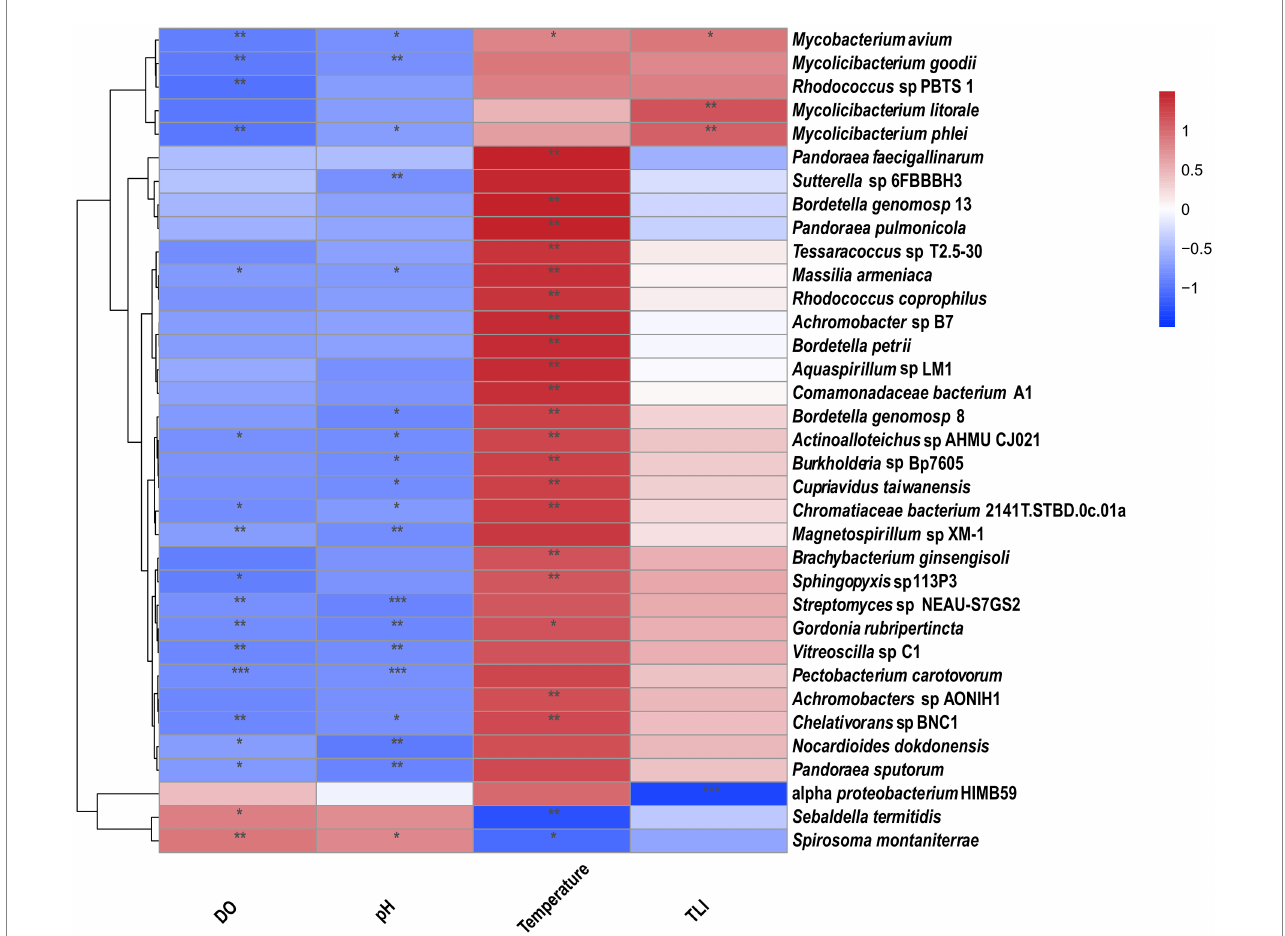
FIGURE 6 Correlation heatmap for microbes and environmental factors. The magnitude of the R -values is shown in the color gradient. * p ≤ 0.05, ** p ≤ 0.01, and *** p ≤